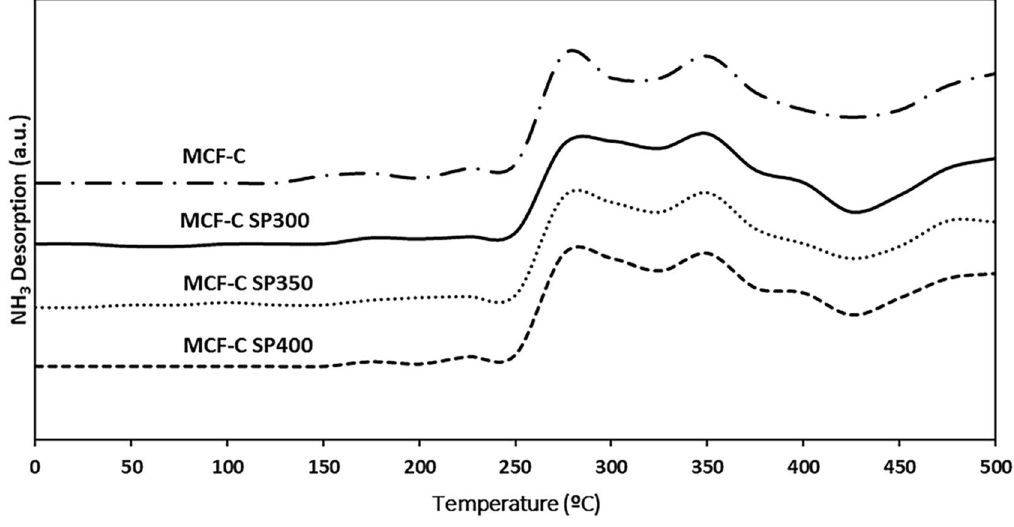
Figure 6. TPD-NH 3 profile of the fresh and spent catalysts.